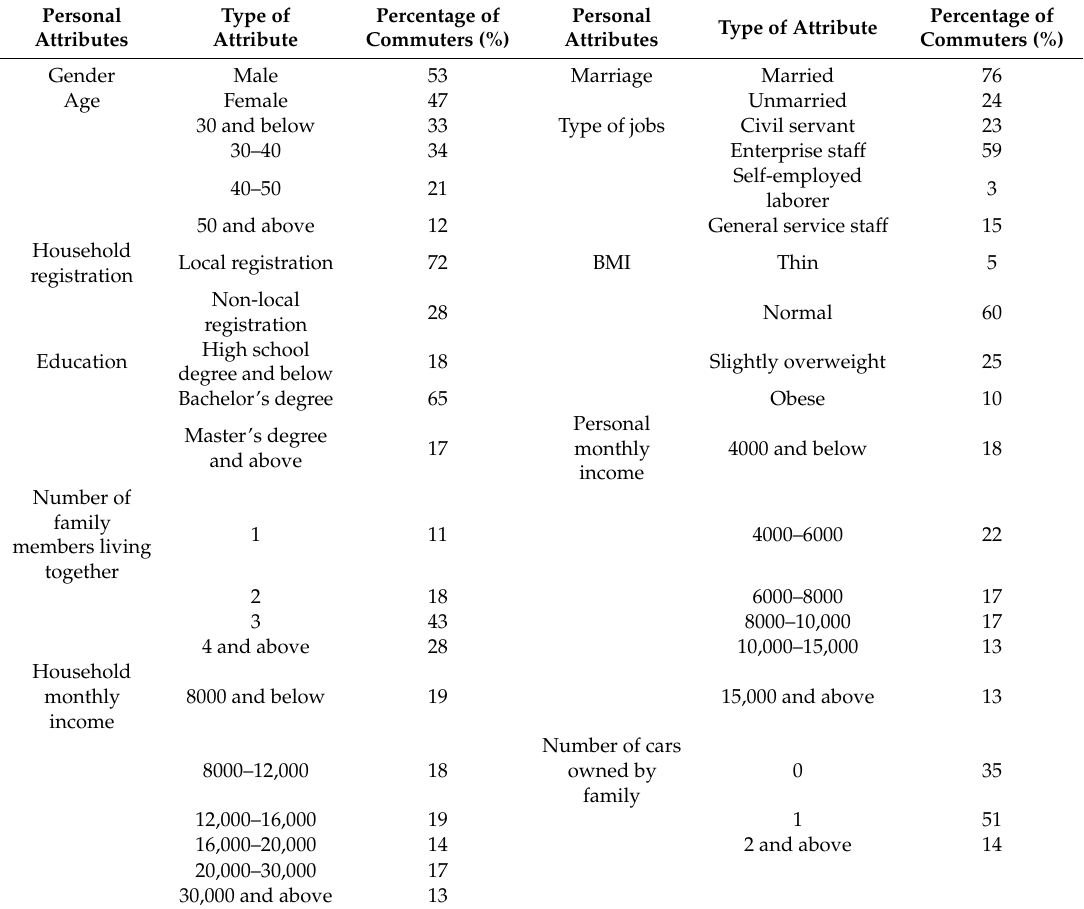
Table 1. Basic personal attributes of